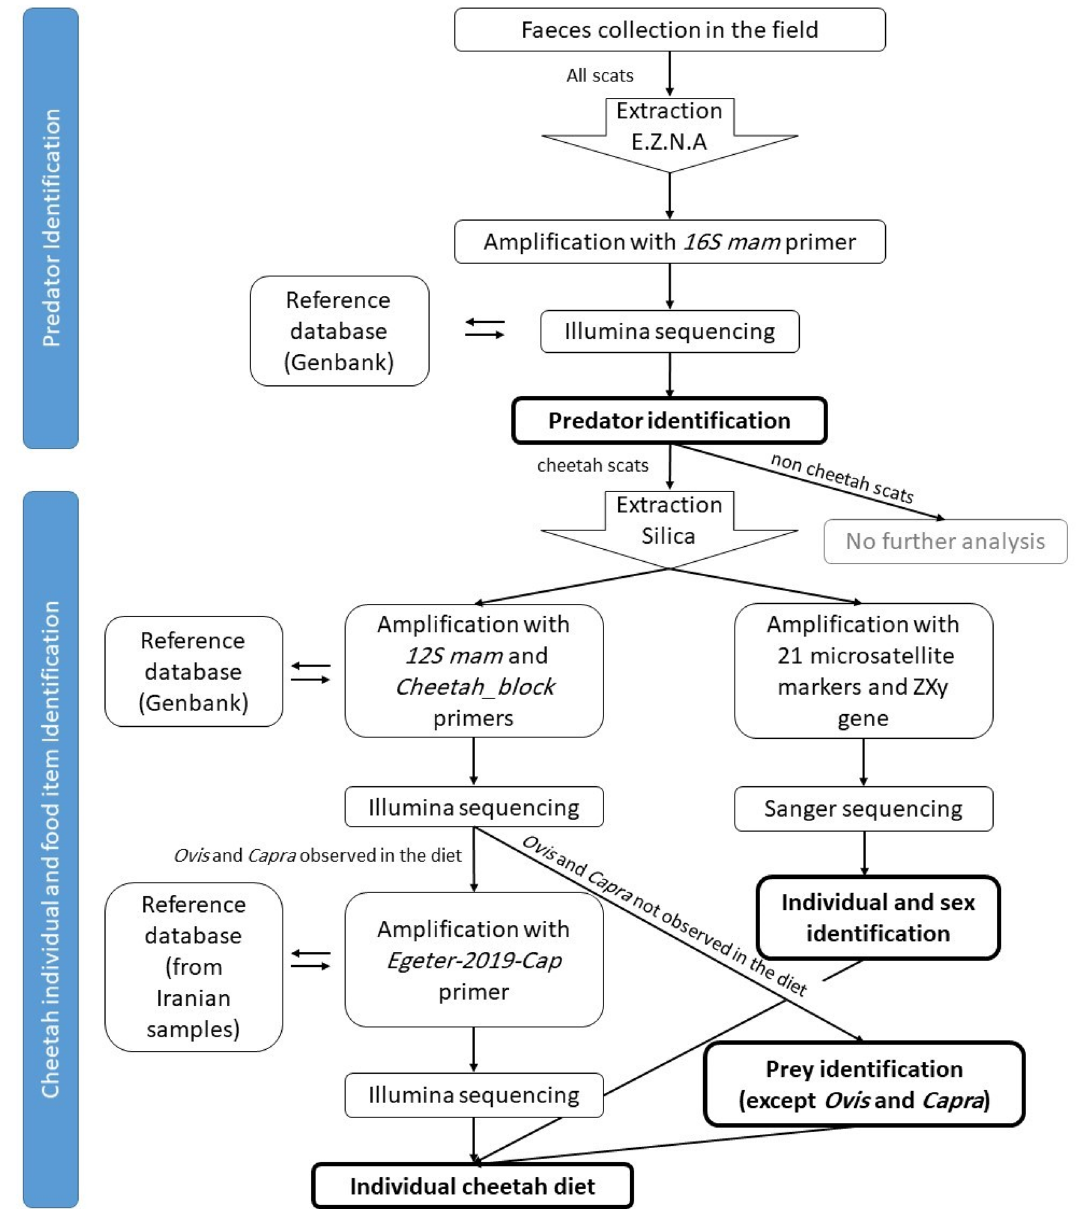
Figure 2. Flowchart diagram, showing the steps of laboratory analysis. Results of steps in boldface are reported in the result section, details on the results of other steps can be found in the Supplementary